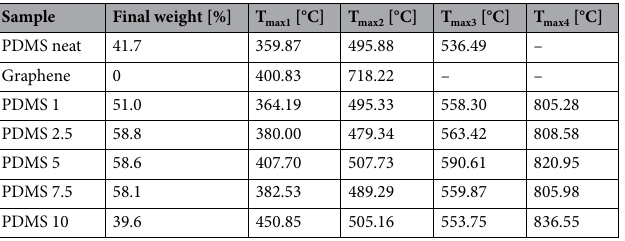
Table 2. Summary of thermogravimetry measurements of graphene/PDMS nanocomposites of 1–10%wt graphene concentration. T max1-4 maximum degradation rate